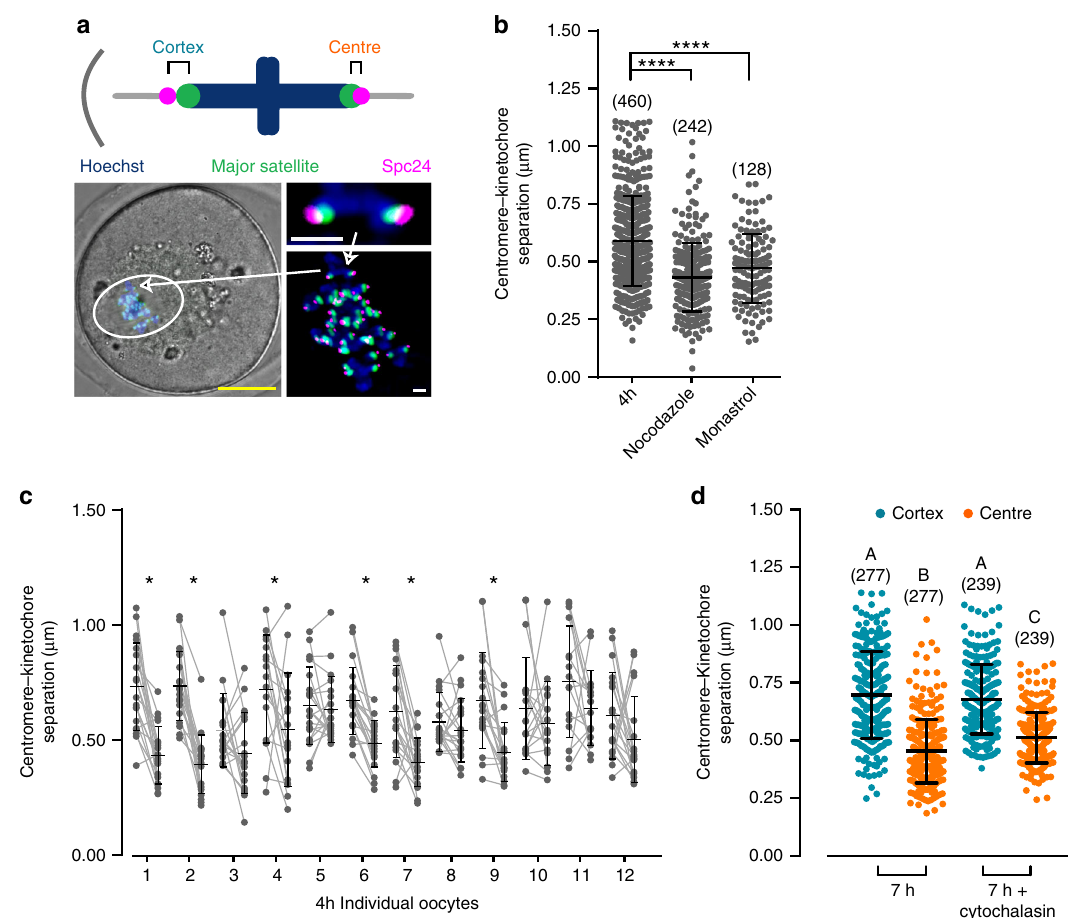
Fig. 4 Bivalents experience greater centromere – kinetochore separation on the cortical side of the spindle. a Schematic to show the location of the probes used and the measurement of central and cortical centromere – kinetochore (C-KT) separation. A representative image to show centromeres (Maj.Sat.- mClover, green), kinetochores (Spc24-mCherry, magenta), and chromatin (Hoechst, blue) in oocytes. Arrow shows the same bivalent at different magni fi cations. Scale bars; yellow, 20 µ m; white, 2 µ m. b All C – KT separations are plotted at 4 h after NEBD following the indicated drug additions (**** P < 0.0001, one-way ANOVA with Tukey ’ s post-hoc test, bivalent numbers are indicated. Measurements were made on 12, 7 and 4 oocytes with 3, 3 and 2 independent repeats, for untreated, nocodazole and monastrol groups, respectively). c C – KT separation distances for bivalents in oocytes 4 h after NEBD. The two centromeres of each bivalent within an oocyte are paired (connecting grey line). Bold lines indicate means and standard deviations. (* P < 0.05, paired t -test, two-tailed). Measurements were made on 12 oocytes, combined from three independent experiments. d Cortical (blue) and central (orange) C – KT separations for oocytes at 7 h after NEBD, with or without prior treatment with cytochalasin B (for 1 h). Bivalent numbers are indicated, with measurements made on 12 oocytes with cytochalasin and 14 without, each combined from three independent experiments. Differences between each group were tested using one-way ANOVA with Tukey ’ s post-hoc test; different letters denote signi fi cant difference ( P < 0.05). b , d Horizontal lines for each condition represent means and the error bars are